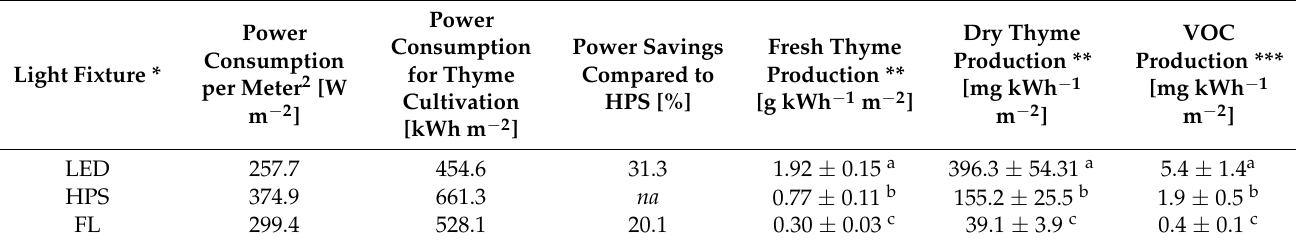
Table 4. Power consumption per square meter of the supplemental lighting fixtures for the production of thyme ( Thymus vulgaris L.) grown in a greenhouse during fall and winter of Berlin,